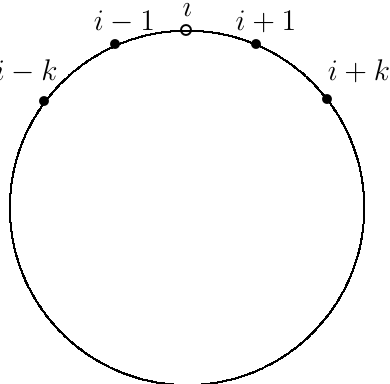
Figure 2 . The circular city model of local